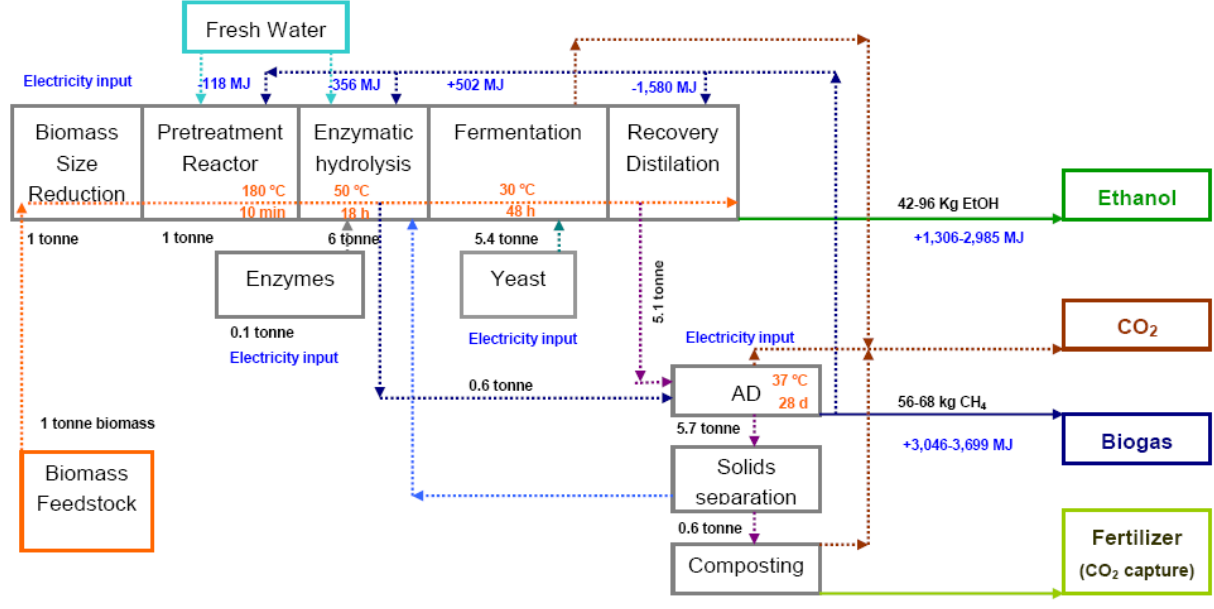
Figure 1. Combined production of bio-ethanol, bio-gas and